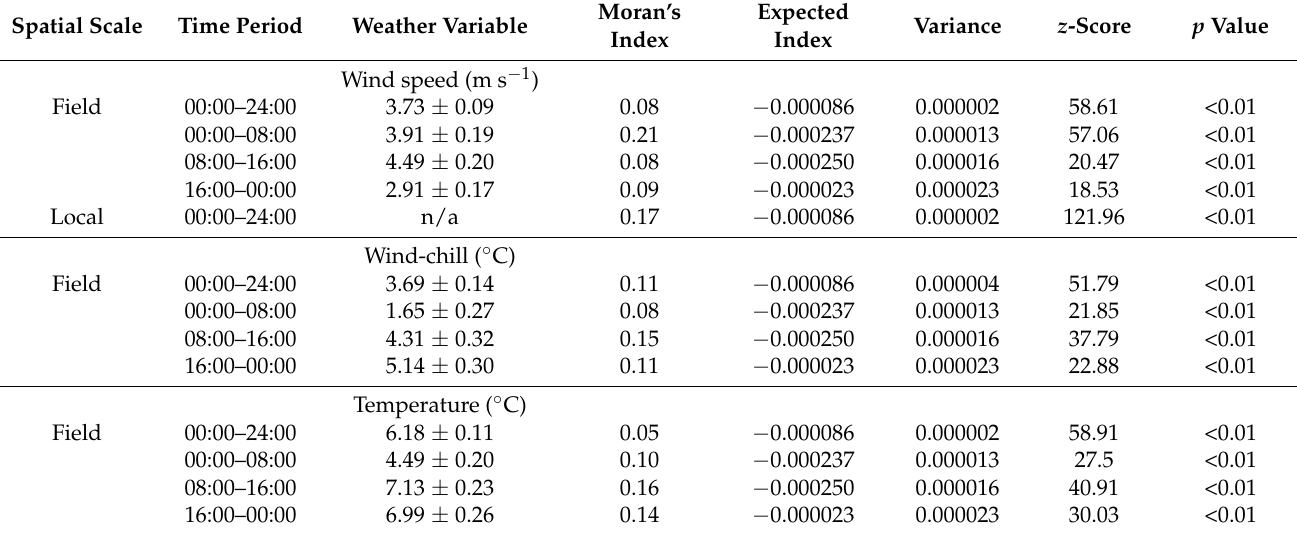
Table 6. Summary of significant Moran’s I values for the weather variables wind speed, wind-chill and temperature at various temporal scales with accompanying temporally stratified mean weather values ± standard error. Moran’s I , on a scale of 0–1, indicates a clustering of high/low values, i.e., clustering of sheep positions when temperature was warmer or